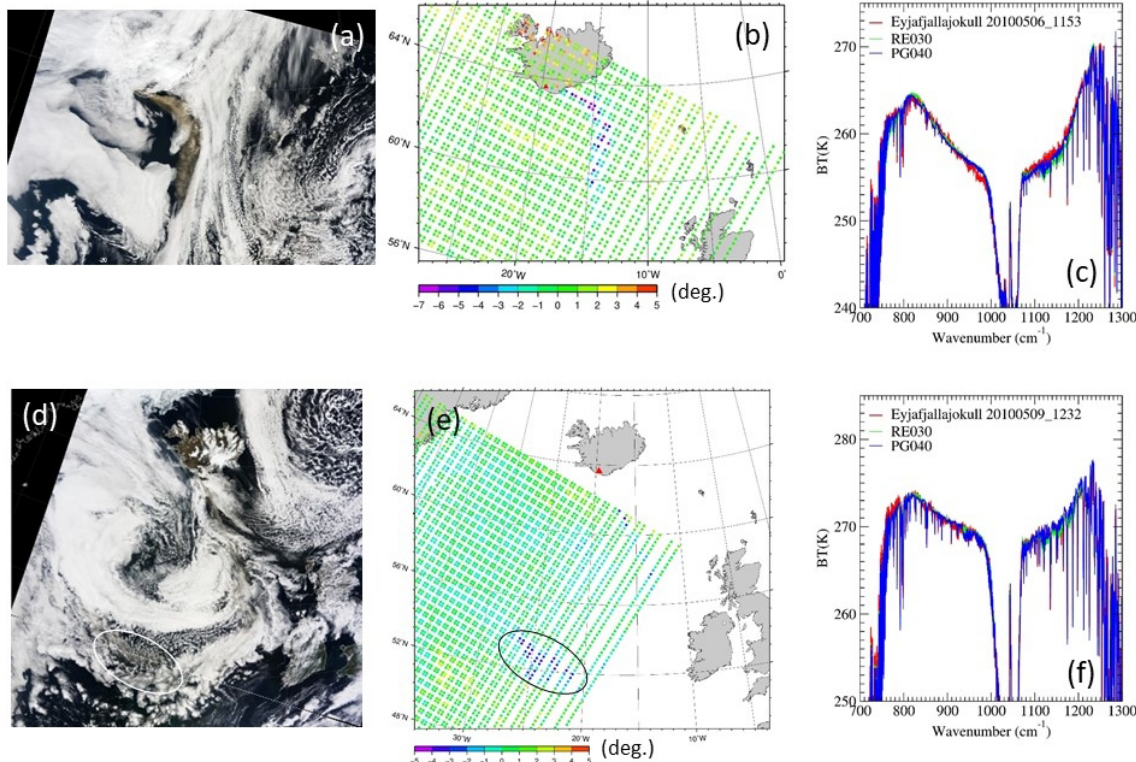
Figure 10. Examples of BTS analyses of the Eyjafjallajökull VAC on 6 May 2010 (a–c) . (a) MODIS true-color image at 11:55UTC and (b) brightness temperature difference (cid:49) BT split measured with IASI at 11:53UTC. (c) BTS of IASI measurement at (lat, long) = (63.146 ◦ N, 15.261 ◦ W) (red), and results of BTS simulations using the RI models RE030 (green) and PG040 (blue). (d–f) The same as (a–c) , but for the VAC on 9 May 2010. The MODIS color image is a composite from 12:25–12:30UTC (d) , and IASI (cid:49) BT split is calculated at 12:32UTC (e) . The area of highly negative (cid:49) BT split is indicated with circles in (d, e) . (f) Measured and simulated BTS for the IASI pixel at (lat, long) = (52.549 ◦ N, 24.075 ◦ W). The retrieved VAC parameters and SO 2 for each BTS simulation are listed in Table